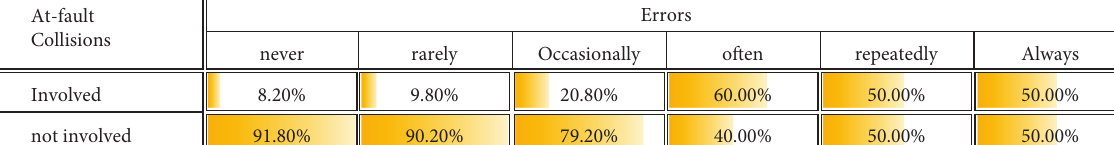
Table 5: The probability of an at-fault collision for heavy vehicle drivers under the condition of